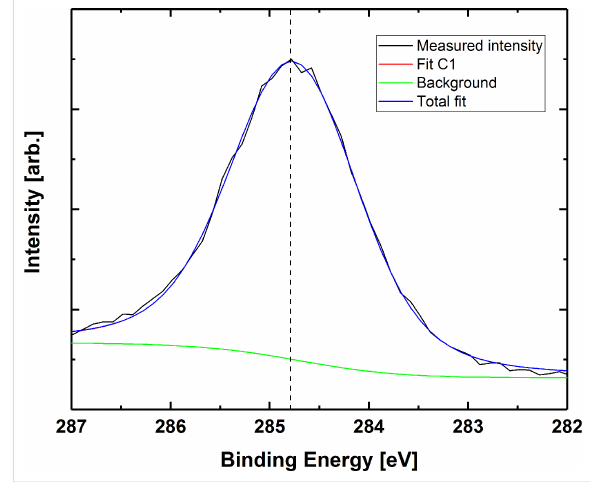
Figure 14: Carbon 1s peak for film based on thymine after water treat- ment. The binding energy is corrected by calibrating with respect to adventitious carbon (284.8